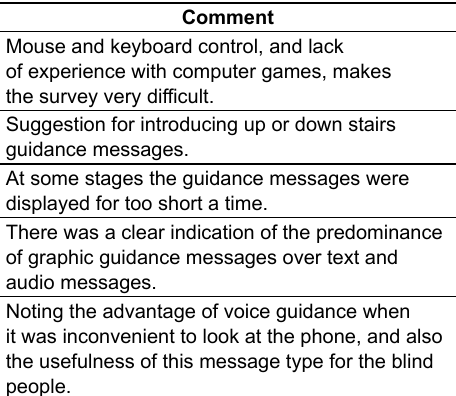
Table 4. Summary of the most common comments from the questionnaire at the end of the study